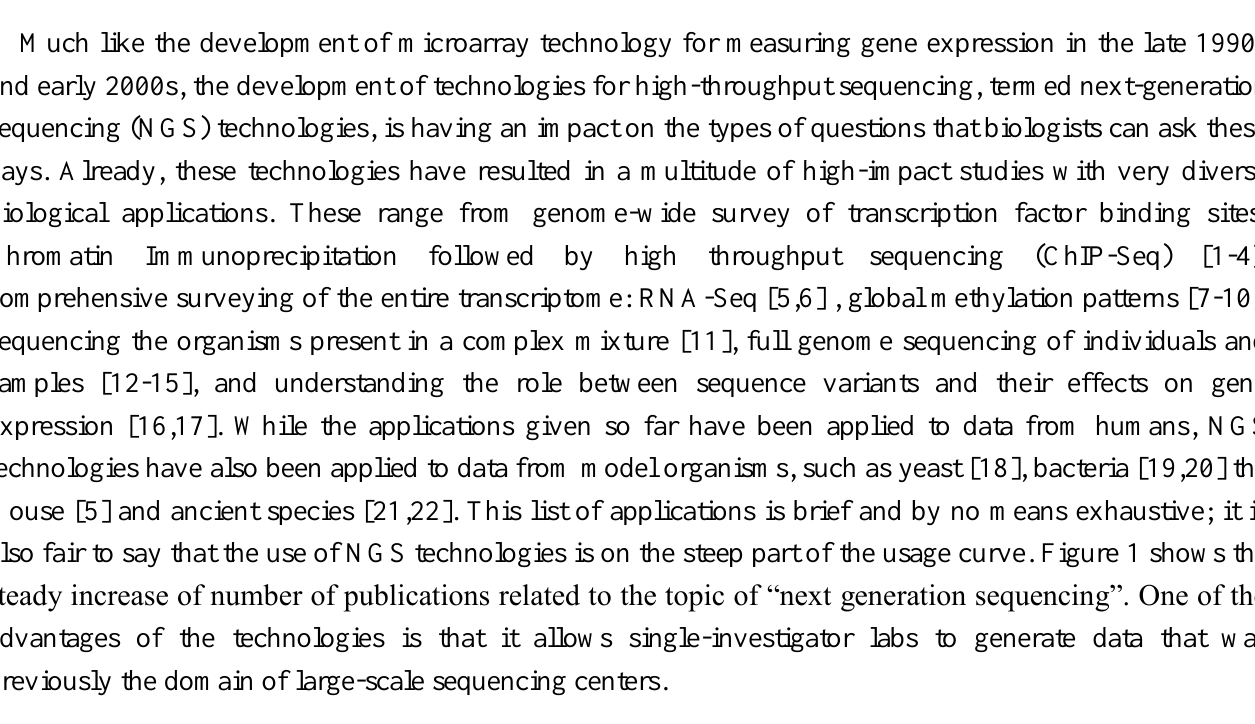
Figure 1. Number of publications by year deposited in PubMed on “Next generation sequencing” (Year 2010 figure is